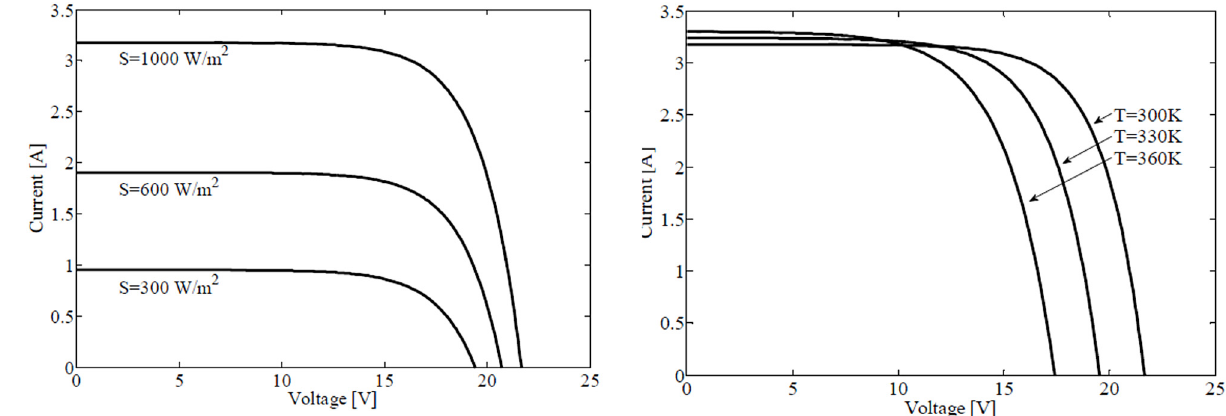
Fig. 4. I – V photovoltaic panel characteristics under different climate conditions.